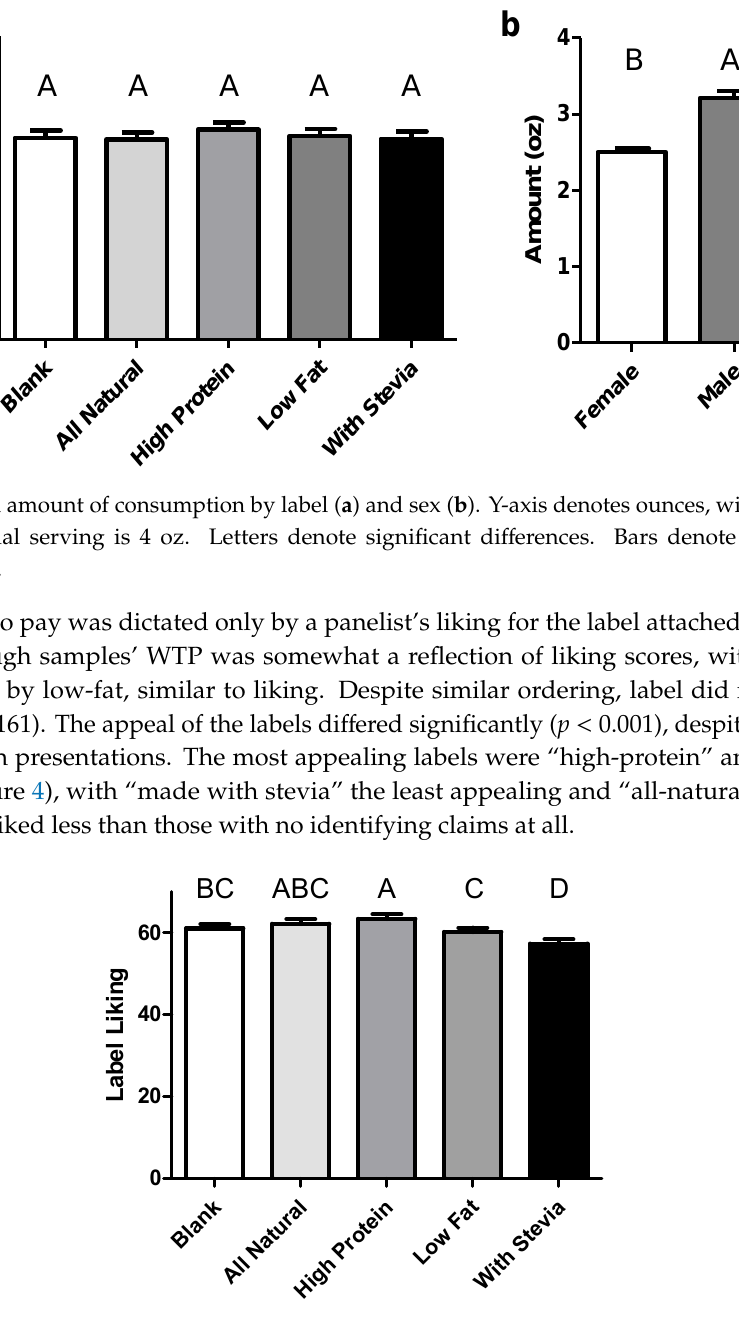
Figure 4. Panelist’s rated their liking of each label rated from 1 to 100 with anchors at 0 (Most imaginable disliking), 16 (Dislike extremely), 27 (Dislike very much), 40 (Dislike moderately), 47 (Dislike slightly), 50 (Neither like nor dislike), 53 (Like slightly), 70 (Like moderately), 73 (Like very much), 83 (Like extremely), and 100 (Most imaginable liking). Letters denote significant differences. Bars denote mean plus standard error.